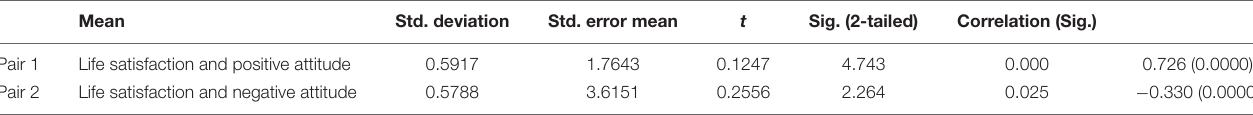
TABLE 7 | Paired samples test and correlations (Section 3: Life satisfaction and attitudes toward COVID-19). Mean Std. deviation Std. error mean t Sig. (2-tailed) Correlation